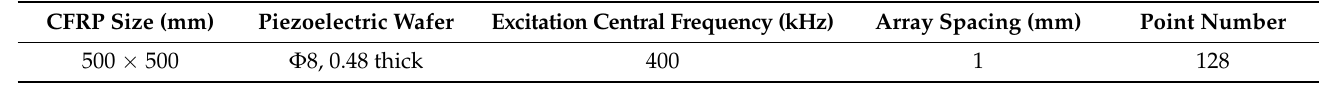
Table 3. Parameters of GW